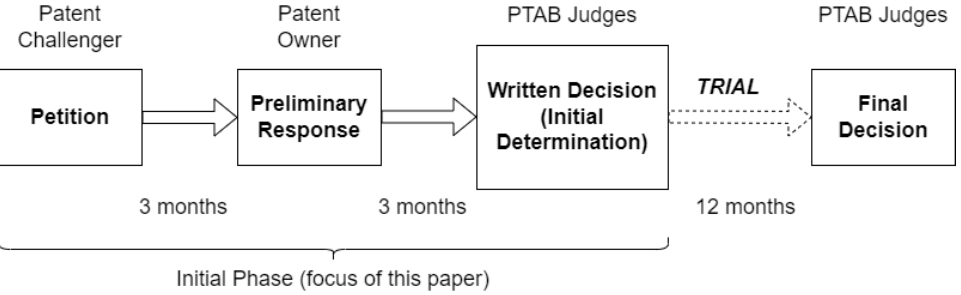
Figure 1. Timeline for IPR, PGR, and CBM post-grant patent review proceedings before the U.S. Patent and Trial Appeals Board (adapted from [23]). The proceeding begins with a petition, and then within 3 months, the patent owner may file a preliminary response brief. No later than 6 months after the petition is filed, a panel of PTAB judges determines whether to institute trial. If they deny trial, the proceeding ends. If they grant a trial institution, then after 12 months of additional briefing, expert depositions, and oral hearing before the judges, a final verdict on patent validity will issue. This paper focuses on the first phase of the proceedings, up to the decision to institute trial, which is also called the initial